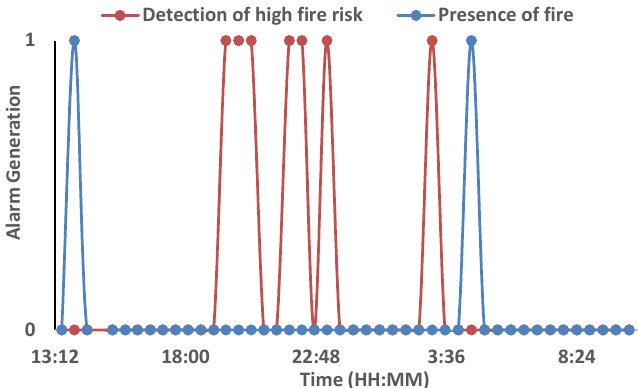
Figure 24. Alarms generated from the data collected by the node.